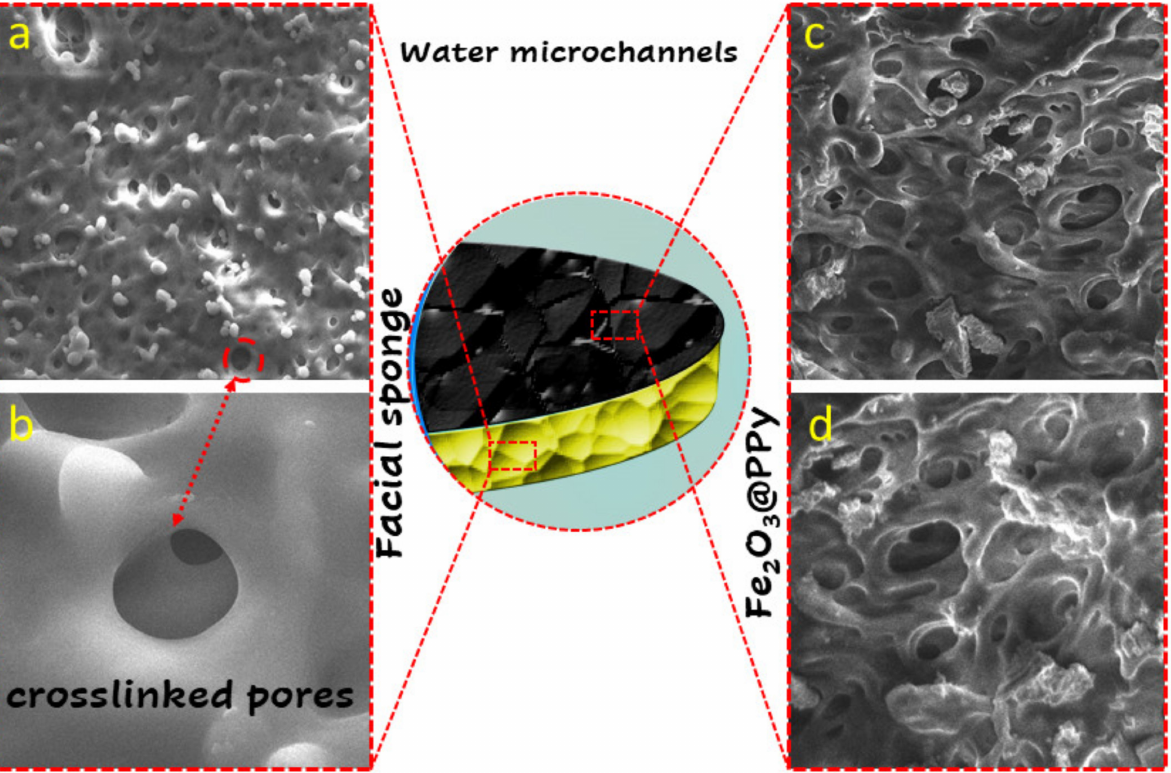
Figure 4. Super hydrophilic and crosslinked water evaporation channels. ( a , b ) FESEM image of the crosslinked open porous structure of super hydrophillic facial sponge. ( c , d ) FESEM image of in-situ polymerized Fe 2 O 3 /facial sponge showing rugged surface texture with intensified pitch-black color with interlinked vertical